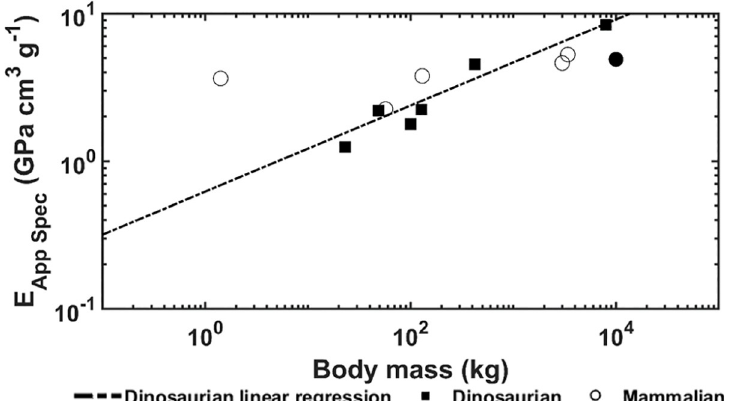
Fig 4. Specific apparent elastic modulus versus body mass. The solid circle indicates the